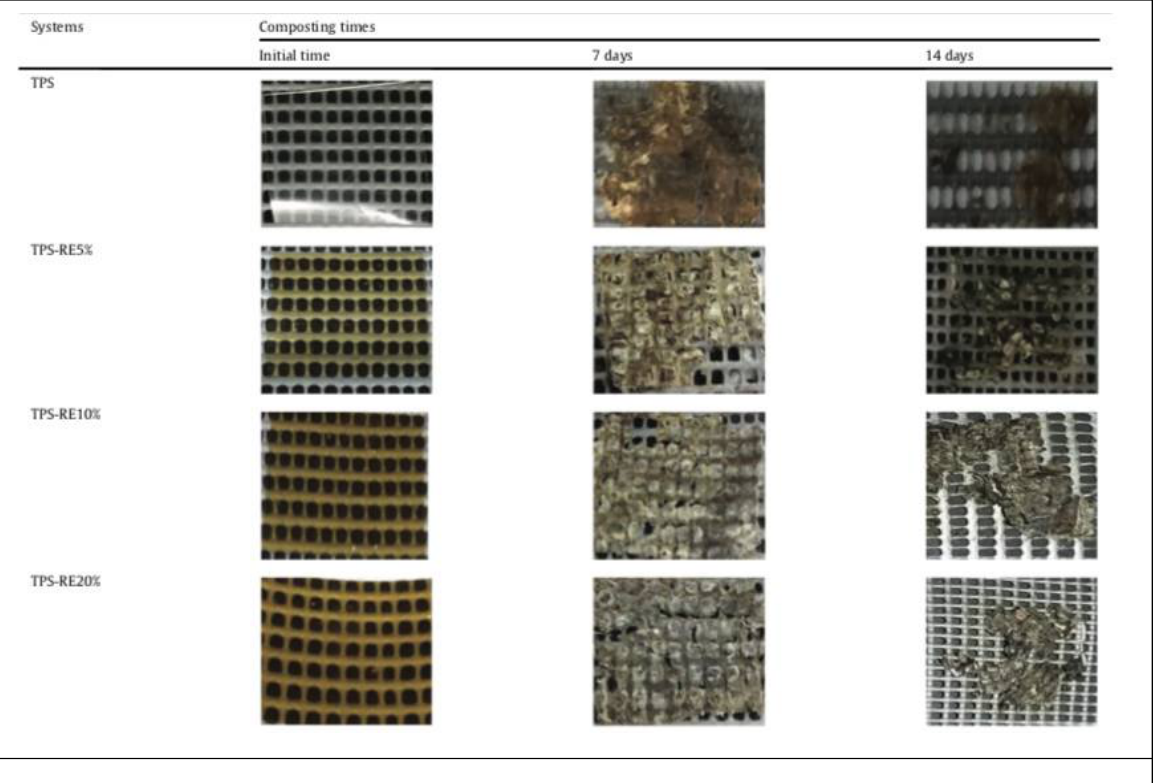
Figure 11: Biodegradation study of cassava starch films incorporating rosemary extracts. Retrieved from (Piñeros et al.,